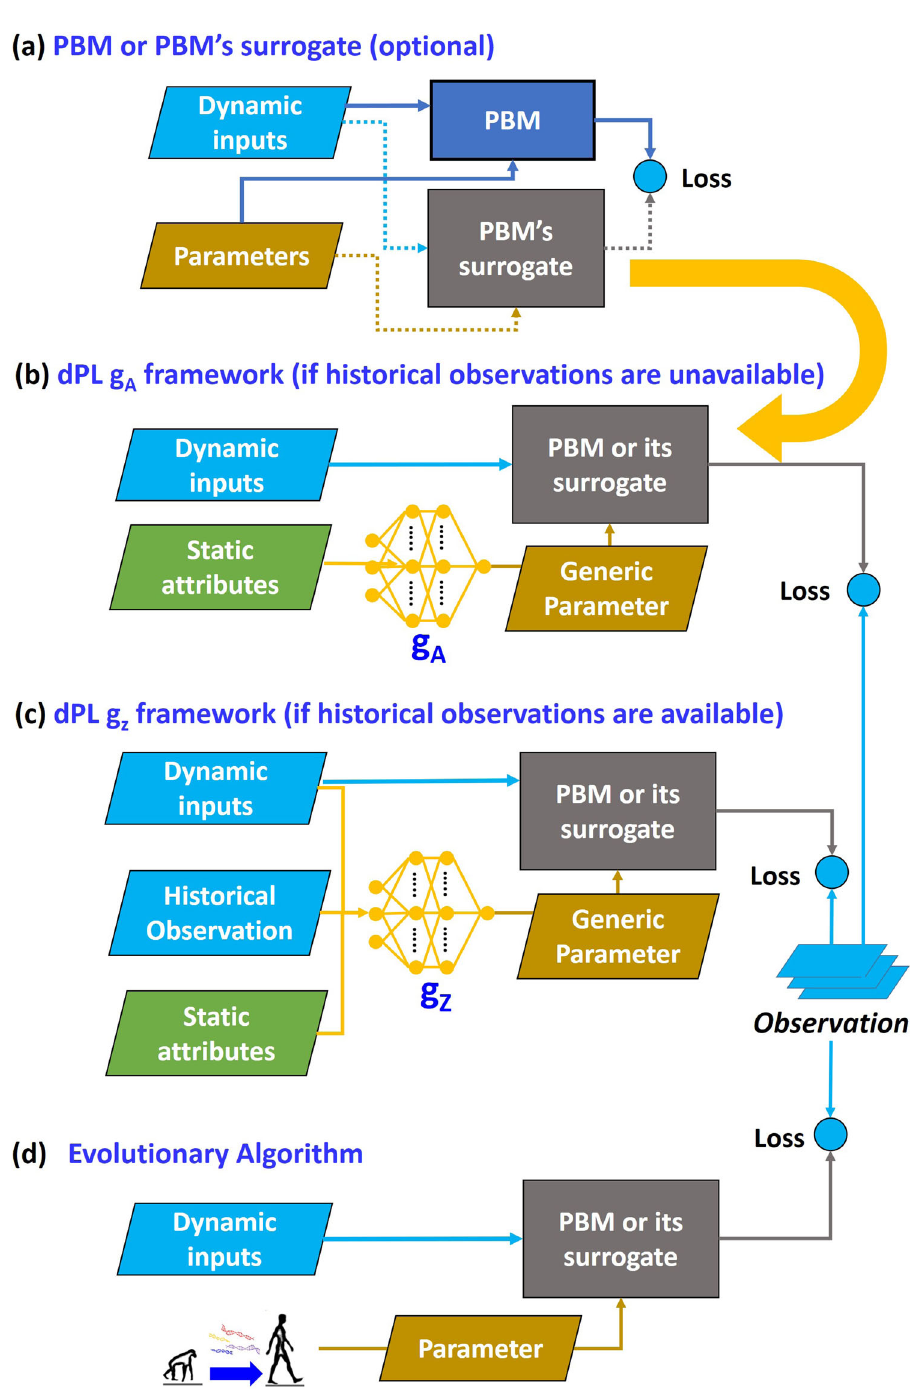
Fig. 1 Comparison of the dPL framework to the traditional calibration paradigm. a A deep learning model is trained to mimic the outputs of a process- based model (PBM). This step is optional since one may also directly implement the model in a DL platform. b Work fl ow of the fi rst dPL option, network g A : parameters are inferred by a network (in our case, a separate LSTM network) based on auxiliary attributes. These parameters are then sent into the PBM, whose outputs are compared to the observations to calculate the loss (the difference between objective function and observation). c Work fl ow of the second dPL option, network g Z : historical observations (meteorological forcings and observed responses) are additional inputs to the parameter estimation network. d Traditional site-by-site parameter calibration